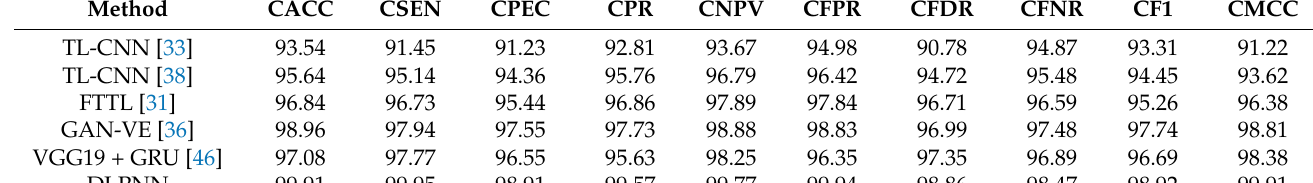
Table 9. Comparison of different methods’ classification performance in percentage.